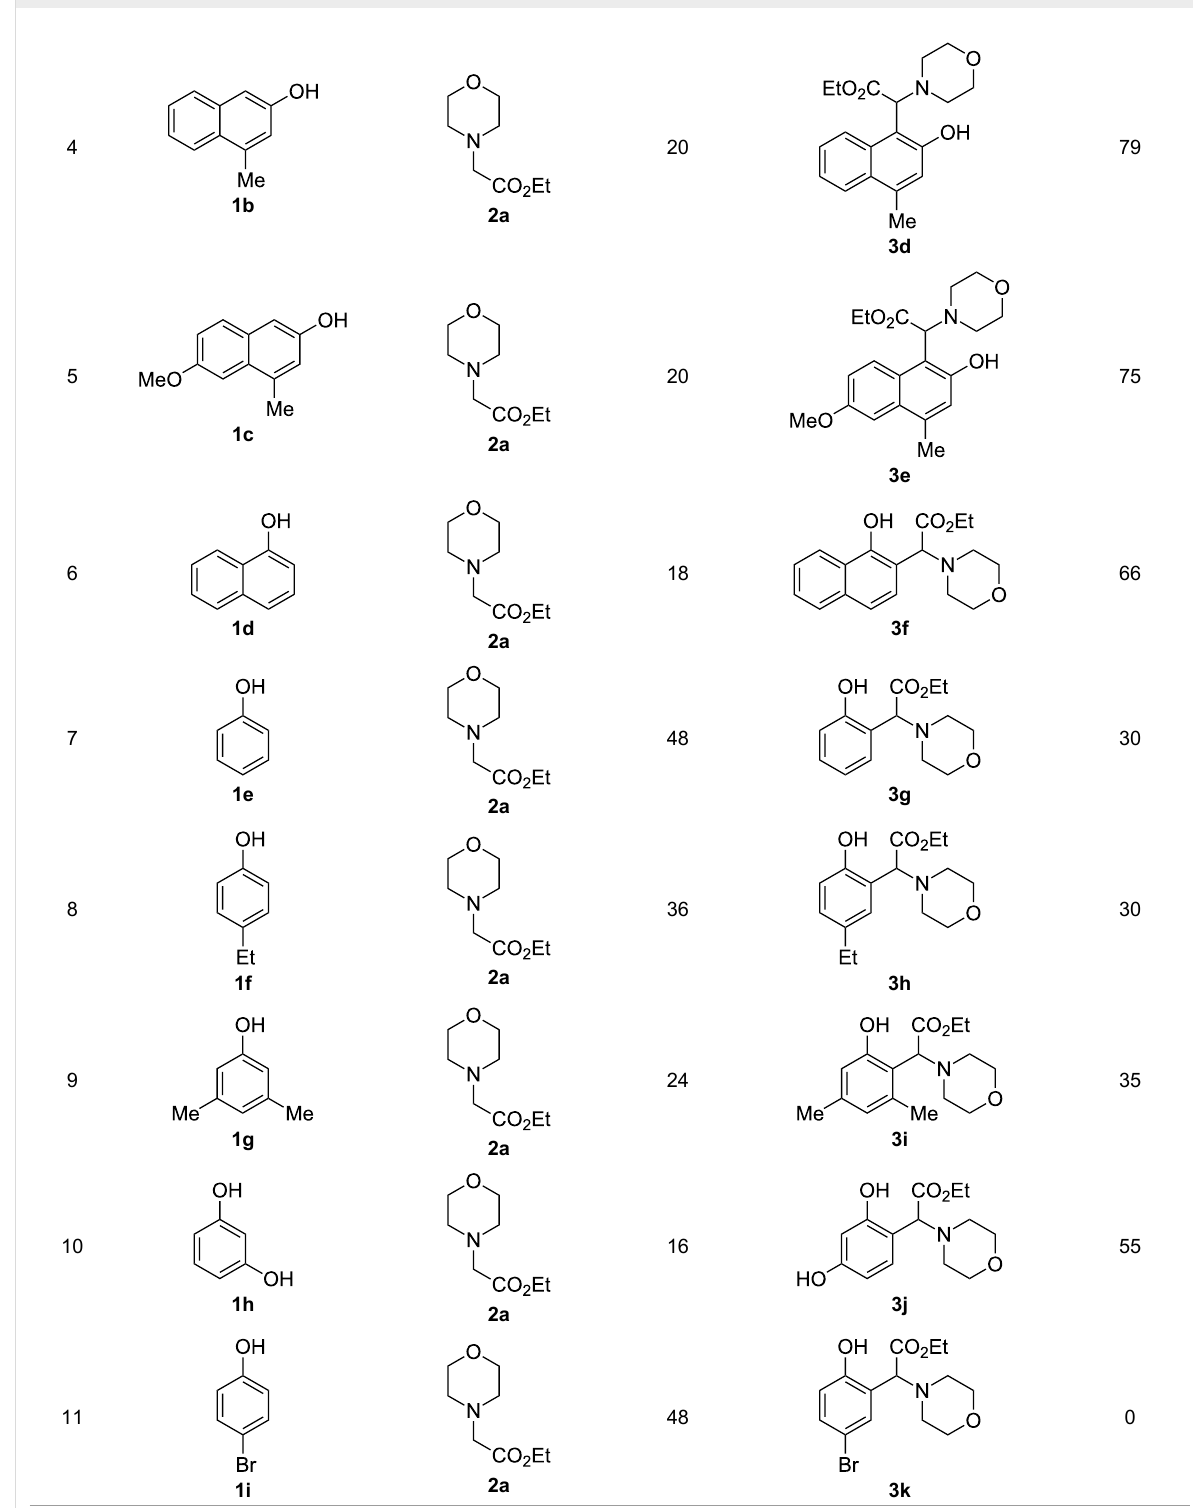
Table 2: Oxidative coupling reaction of naphthols and phenols with α -amino esters. a